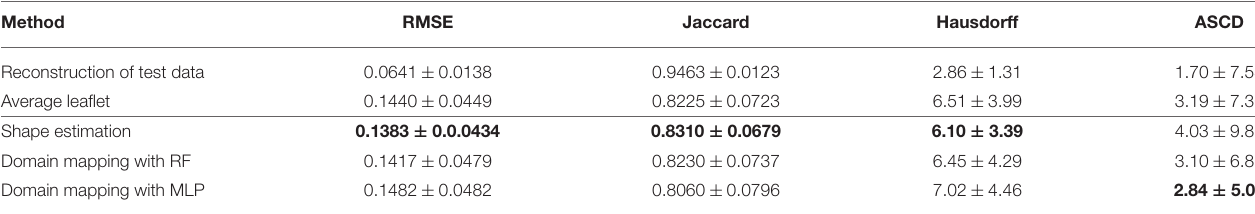
TABLE 4 | Accuracy of leaflet shape prediction for all methods, regarding RMSE, Jaccard similarity, Hausdorff distance, and